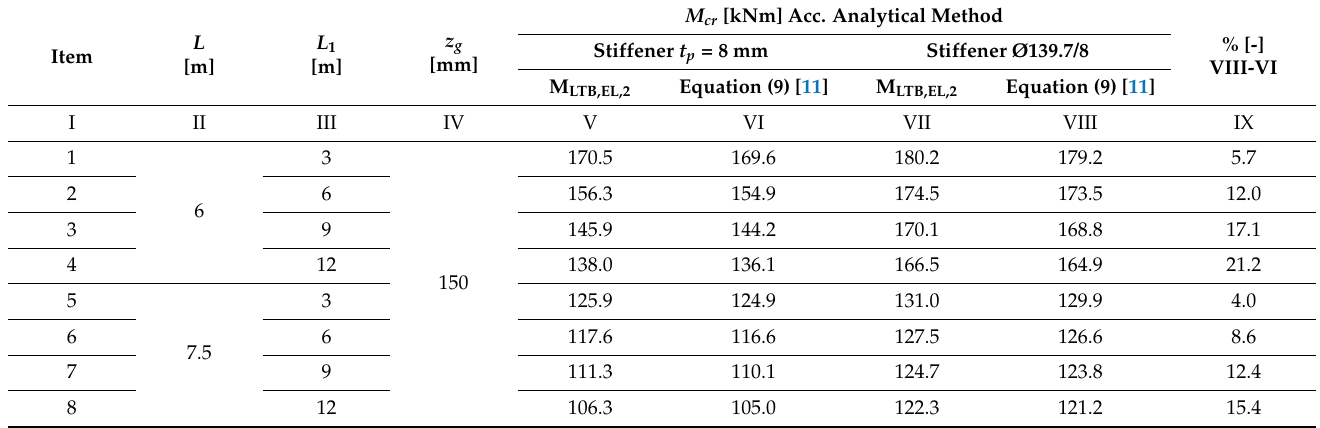
Table 4. Critical moment ( M cr ) of the critical beam B–E of H-shaped grillage, uniformly loaded ( z g = + h /2), from analytical methods.